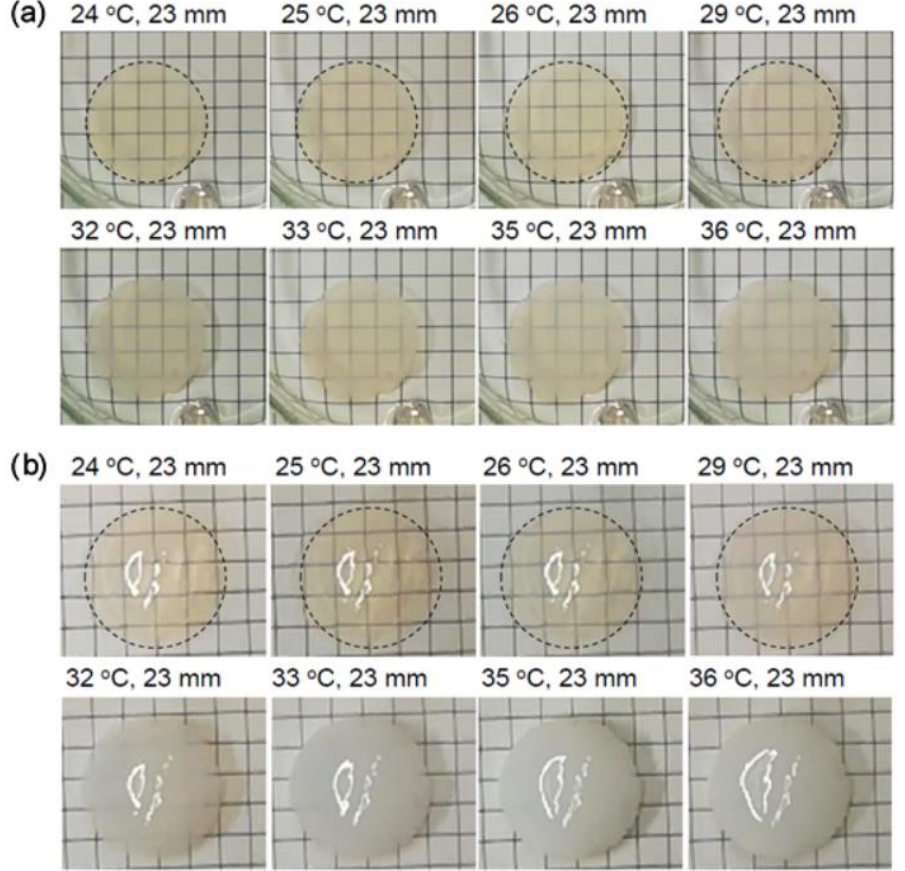
Figure 1. Top-view photographs of ( a ) P1a-gel and ( b ) P1b-gel with a pellet shape in chloroform during the heating process (~3 °C/min). The values inserted above each picture denote the temperature and the diameter of the gels. Dashed circles were drawn as visual guides for the outer shape of the gels. Each square of the grid corresponds to 5 mm.